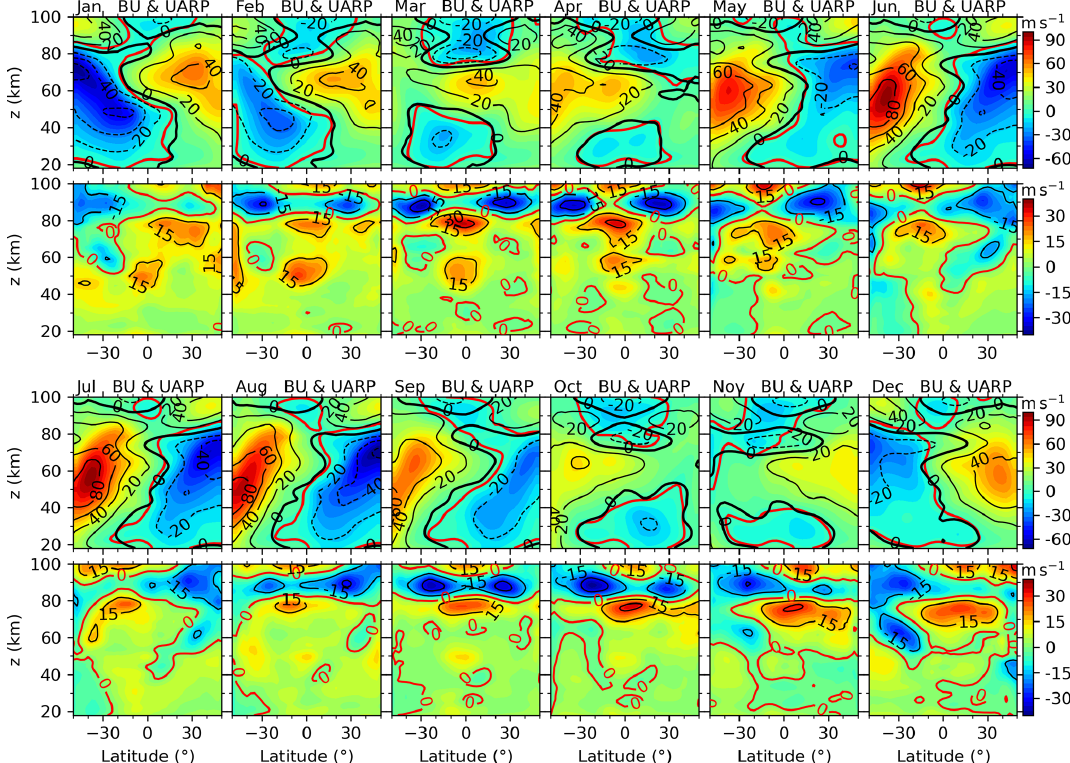
Figure 6. Latitude–height sections of BU (color-filled contour, positive for eastward) and UraU (contour lines with interval of 10ms − 1 , the eastward and westward winds are represented as solid and dashed lines, respectively) in each month (denoted in the upper-left corner of each panel) of a composite year. The thick black and red contour lines are the zero wind of UraU and BU, respectively. The same color scale is used for all